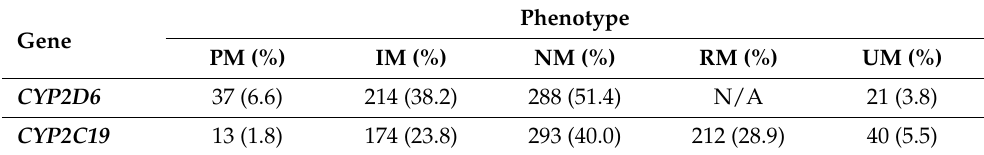
Table 6. Phenotype distributions for CYP2D6 and